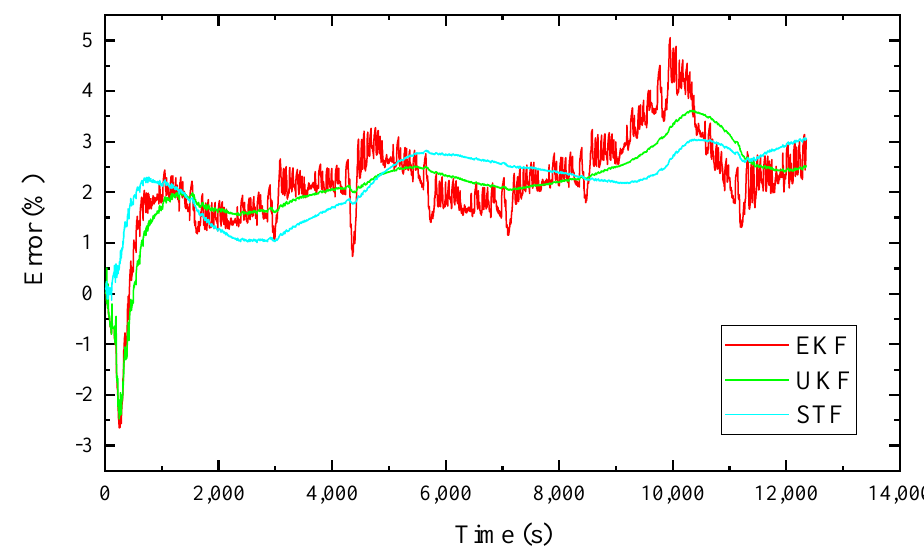
Figure 16. The estimated SOC error of the algorithms with −5 mV voltage offset at 30 °C . Table 6. The MAE and RMSE of three algorithms when with voltage measurement offset. Algorithm